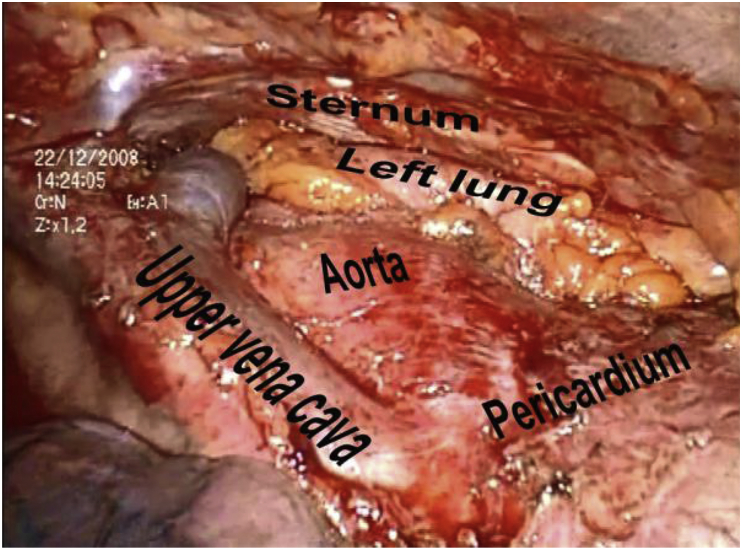
Intraoperative view.